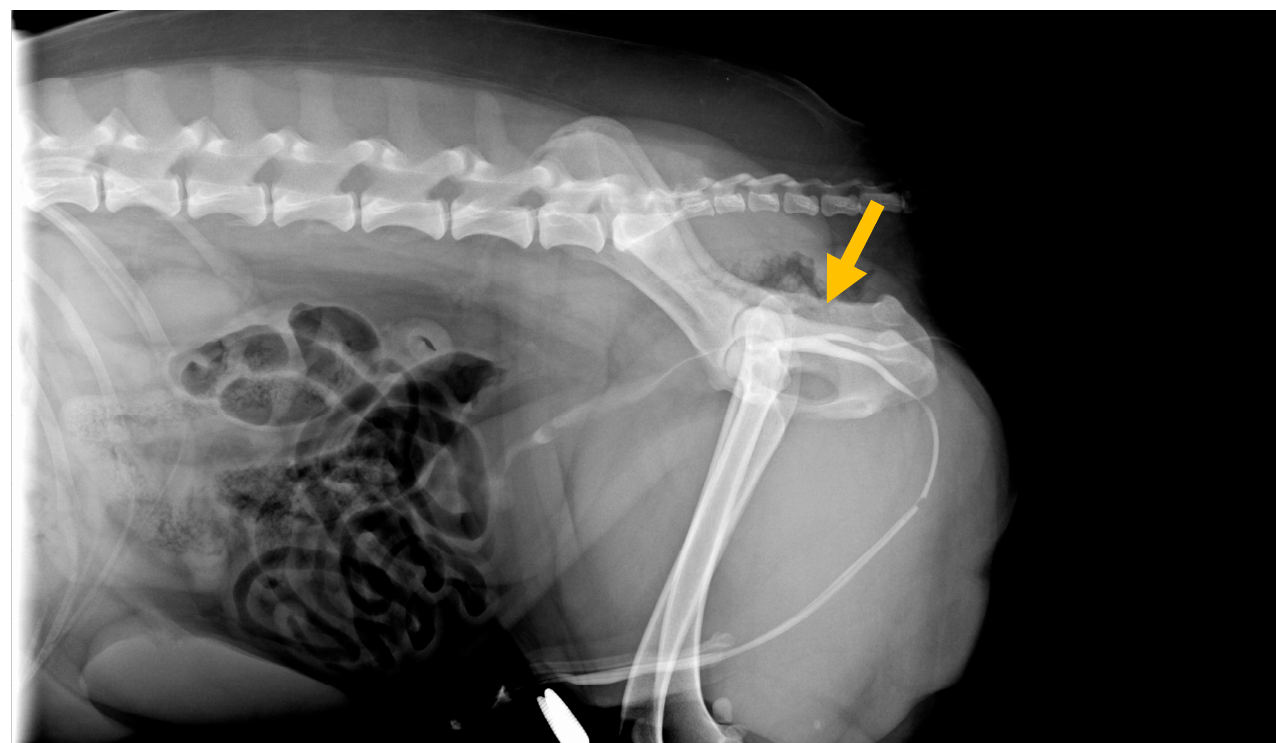
Figure 2. Radiographic image (lateral view) obtained during positive-contrast retrograde urethrocystography, highlighting a normal distal urethra and an accessory urethra. Note the contrast filling of Y-type urethral duplication at time of diagnosis, showing the pelvic urethral opening on the outside.